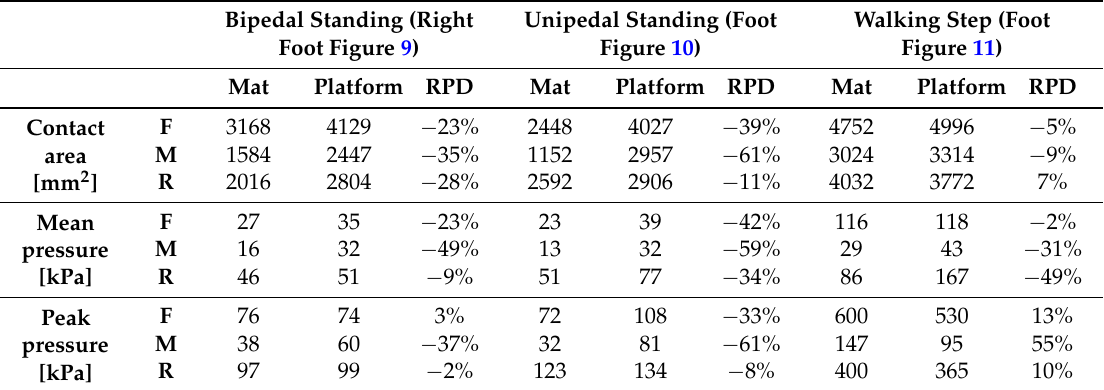
Table 1. Example of parameters and relative errors for a single trial of bipedal standing, unipedal standing, and walking. Data was extracted from the pressure maps shown in Figures 9–11. Parameters were calculated for each foot zone: Forefoot (F), midfoot (M), and rearfoot (R). Platform values are taken as reference for calculating relative percentage differences (RPD).